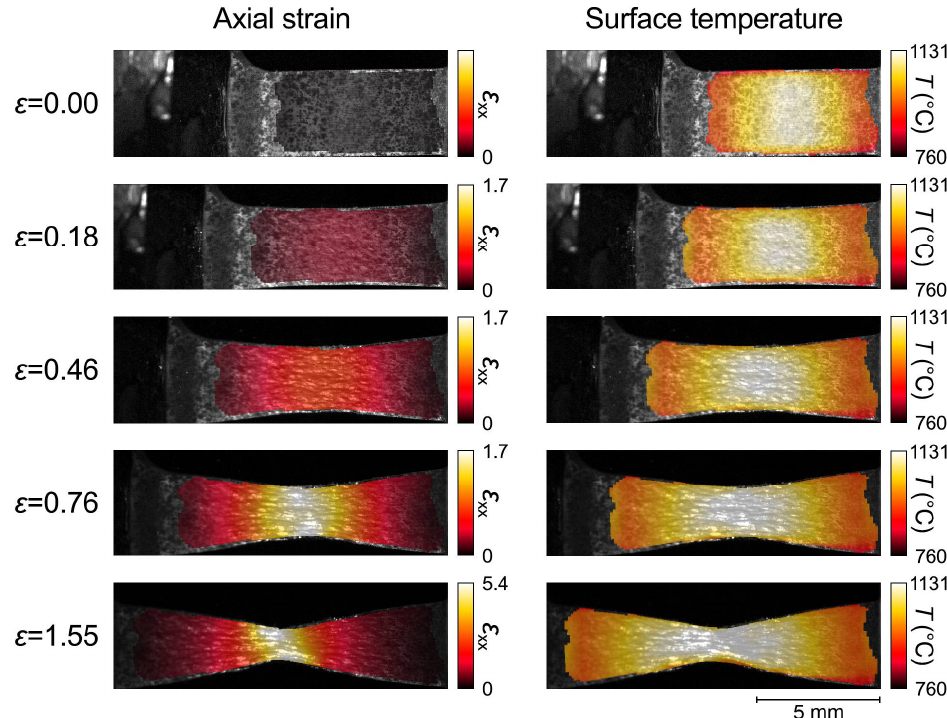
Figure 18. Full-field axial strains and surface temperatures at different global engineering strains in a commercially pure titanium specimen loaded in tension at an average initial temperature of 1120 °C and a strain rate of approximately 1600 s −1 .